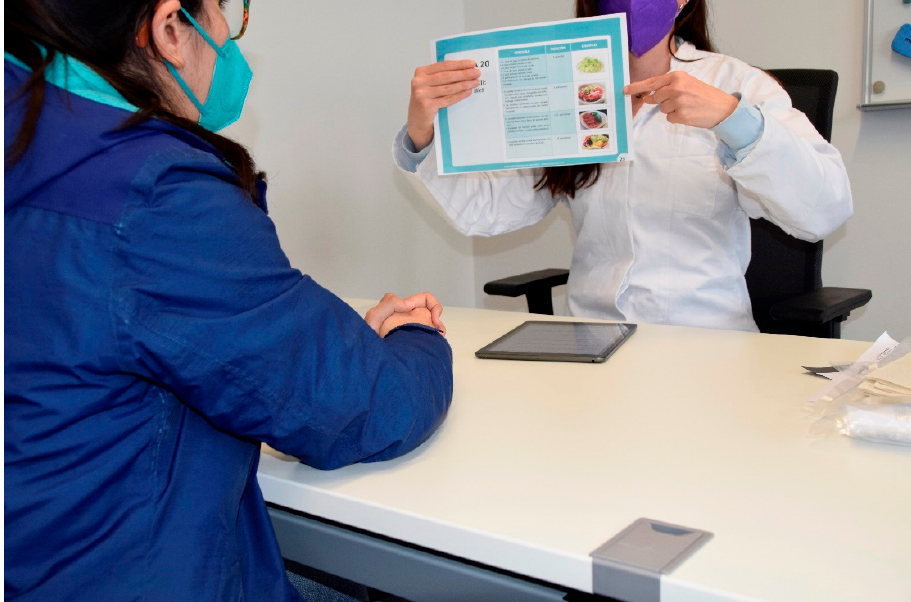
Figure 3. Visual aids are used during the interview with the first module of the EULAT eCollect application (Socio-Demographic Interview), which displays different questions depending on the type of participant, patient characteristics (e.g., gender), and previous answers, allowing for a significant reduction in interview time.